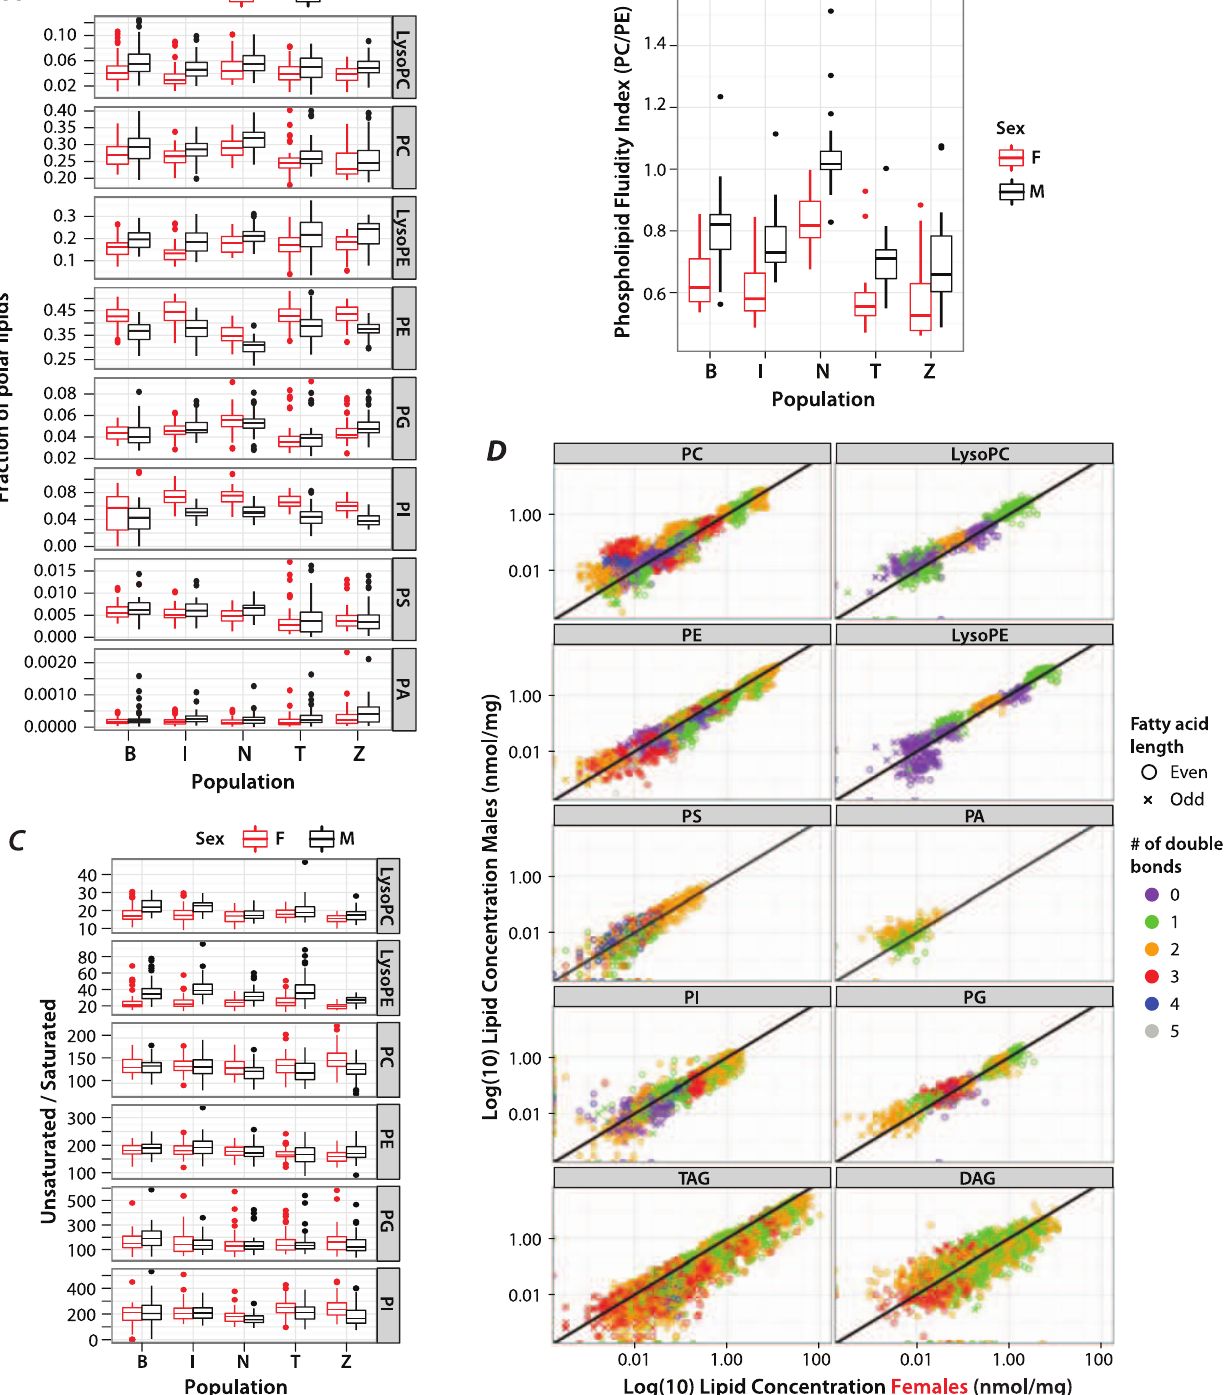
Figure 2. Distribution of lipids and membrane fluidity. A: Proportion of total polar lipids comprised by each polar lipid class in the five populations, stratified by sex. B: Membrane fluidity index as determined by the PC/PE ratio for all populations and sexes. C: Ratio of unsaturated over saturated lipids grouped by lipid class, population and sex. A lipid class was only included if it contained saturated lipids. D: Log-transformed concentration of all lipid species in all lipid classes in males vs . females. Samples are color-coded by the number of double bonds and the FA length is partitioned into odd (x) and even (circle) groups.